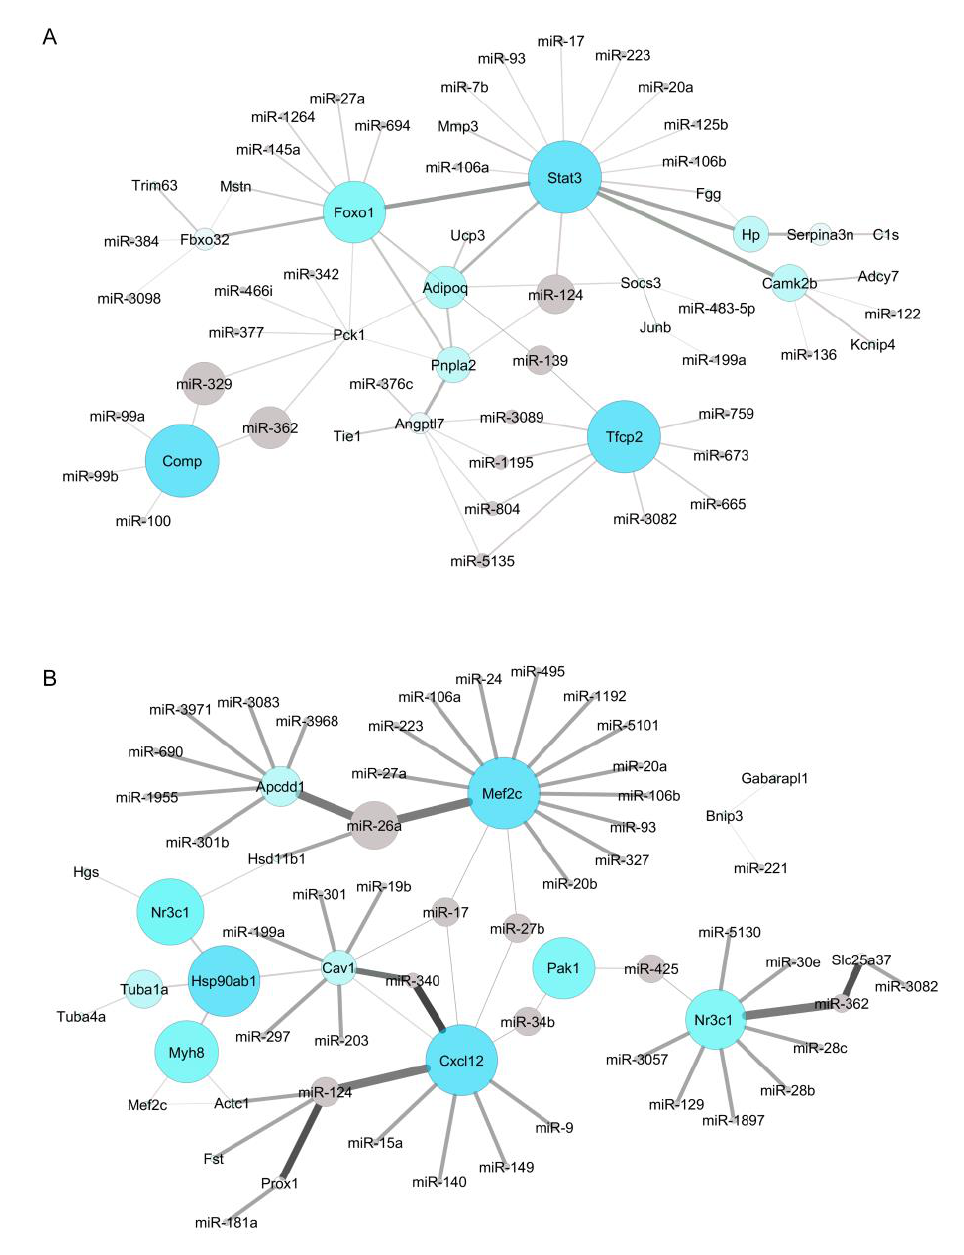
Figure 4. The miRNA–mRNA target interaction network in muscle wasting in cancer cachexia. ( A ) Interactome between up-regulated genes and the respective potential regulatory microRNAs. The larger the circles, the higher the number of interactions identified. Gray lines highlight the interactions; line thickness reflects the betweenness centrality. ( B ) Interactome between down-regulated genes and the potential regulatory microRNAs. The larger the circles, the higher the number of interactions identified. Gray lines highlight the interactions; line thickness refers to the betweenness centrality. MicroRNA–gene interactions were visualized using Cytoscape